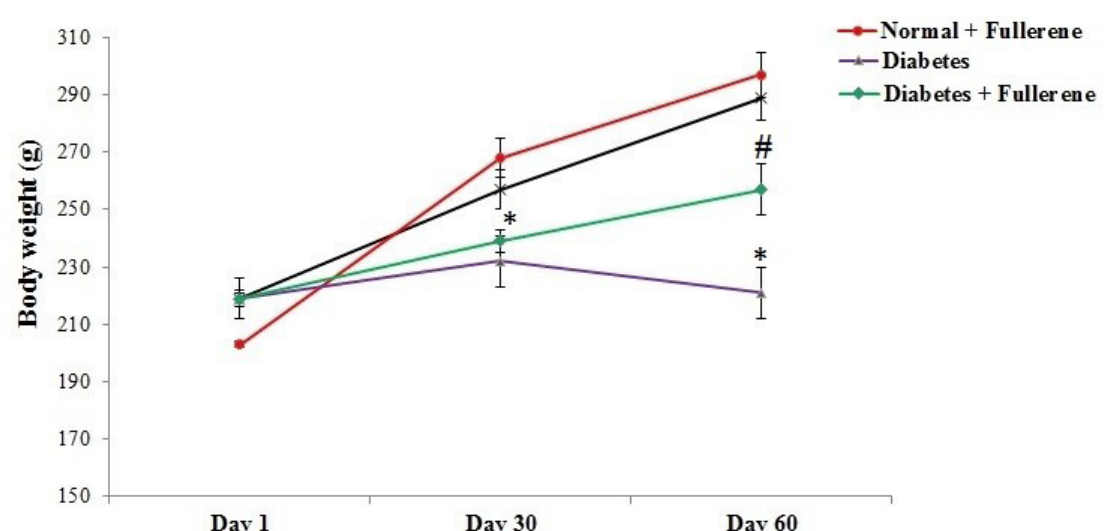
FIGURE 2 - Effects of fullerene on body weight on days 1, 30, and 60 after STZ injection. Differences in measured parameters among 4 groups analyzed by using One-way ANOVA, followed by the Tukey post hoc test. All the data were presented as mean ± standard deviation of the mean. The symbol * and # denote significant differences with the normal and diabetic groups, respectively; *P<0.05 and #